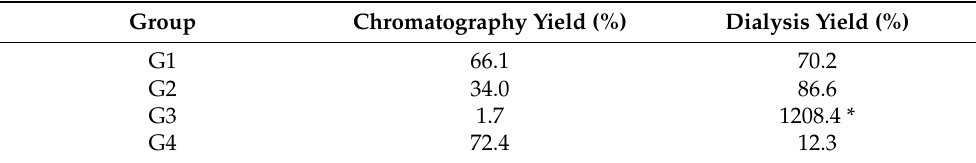
Table 5. eGFP yield for chromatography and dialysis by each working group.